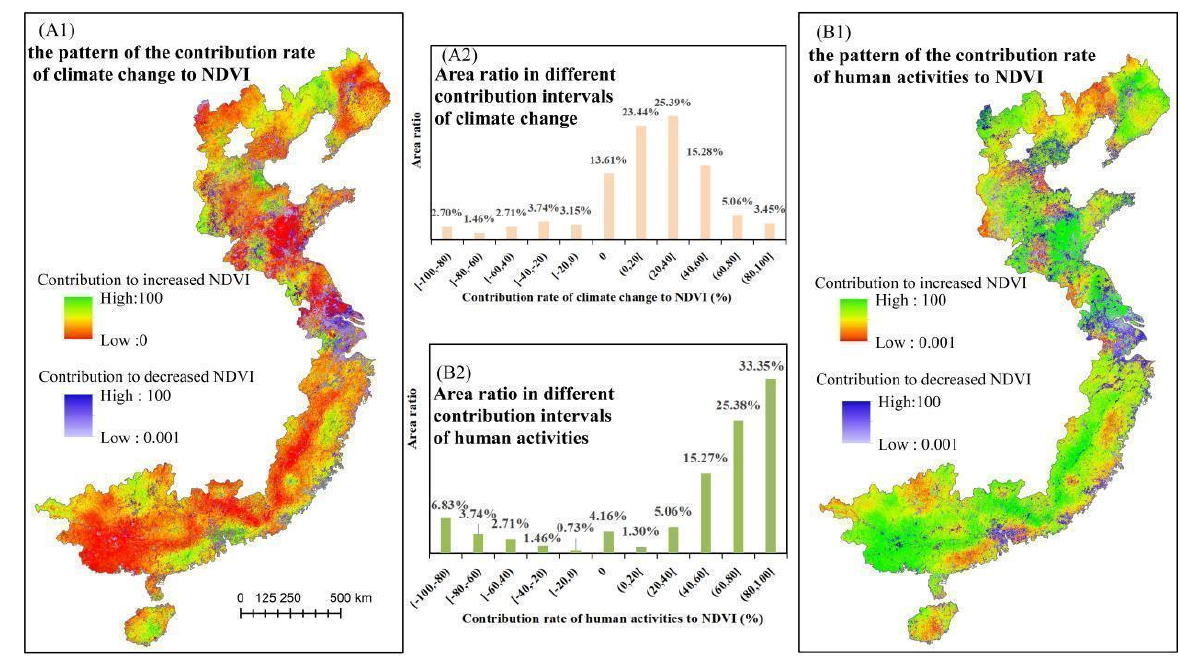
Figure 4. The relative contribution of driving forces to vegetation dynamics.